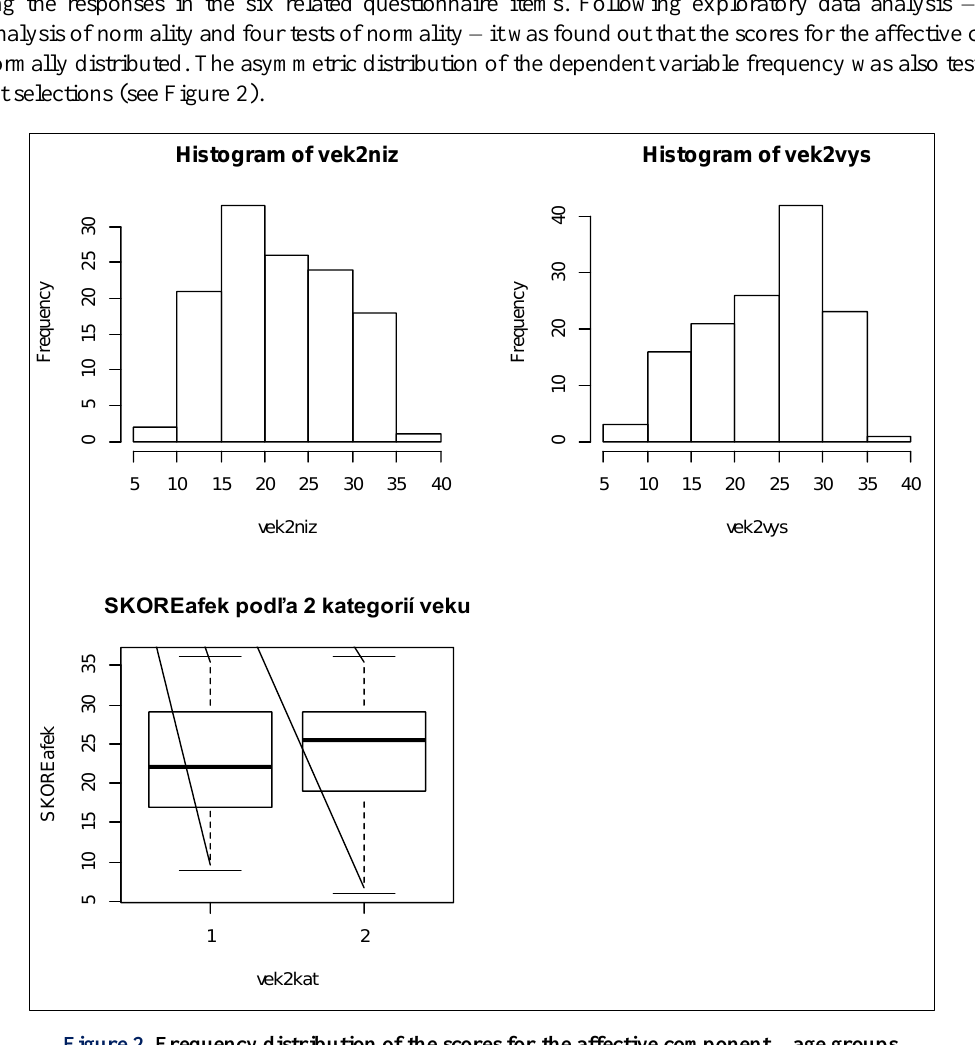
Figure 2. Frequency distribution of the scores for the affective component – age